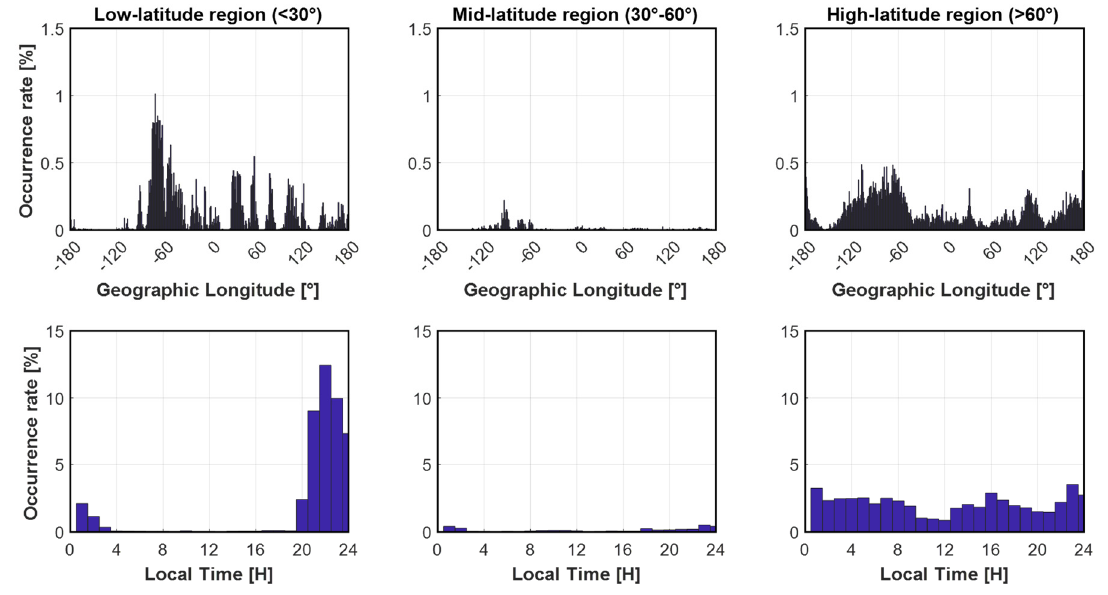
Figure 16. Distribution of ROTI values by longitude ( above ) and by time ( below ) in three different zones of the Earth (only ROTI ≥ 0.5 TECU/min are counted). While the mid-latitude areas show almost no irregularities, as was predicted, the high-latitude areas are the regions where ionospheric irregularities can occur randomly at any longitude and at any time of the day. The appearance rule is most straightforward in the low-latitude regions, with the appearances occurring only at night and mostly concentrated at a longitude of 60 ◦ W (the South America